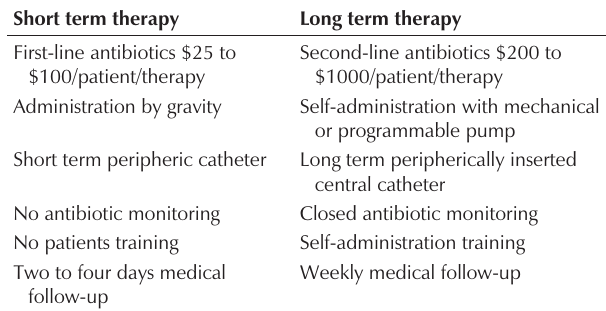
Efficiency of clinical re-engineering process at Hôpital